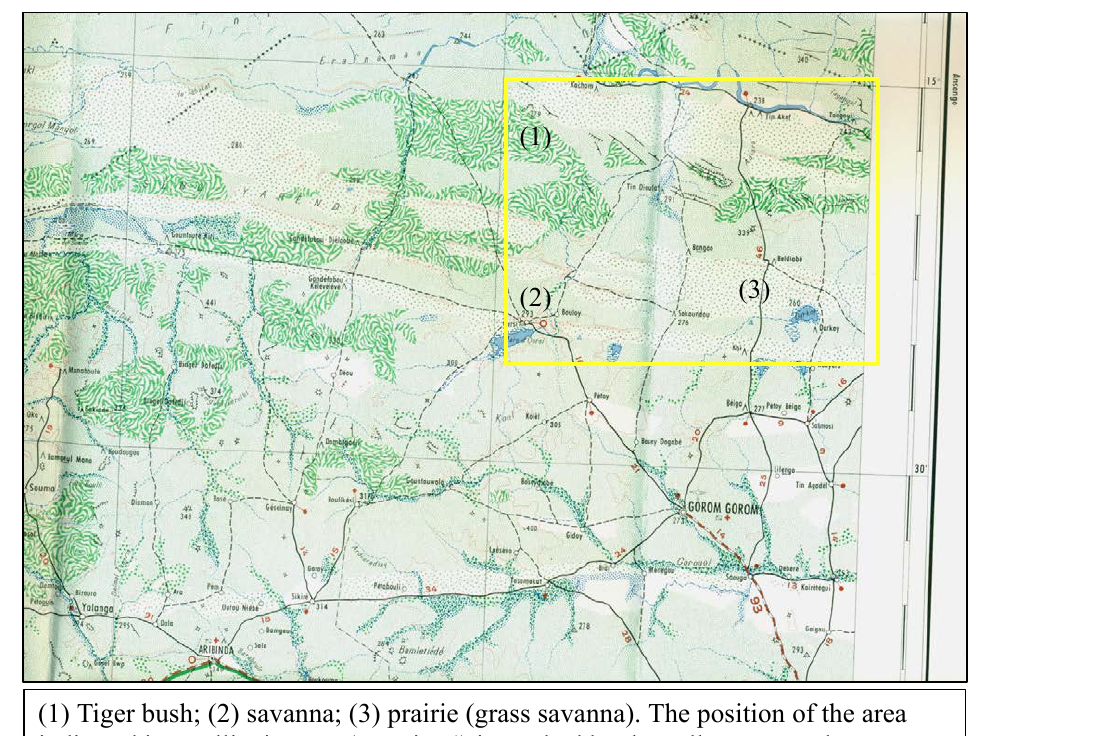
indicated in satellite images (see Fig. 4) is marked by the yellow rectangle. Figure 5. Section of the topographic map for Hombori (IGN, 1961) indicating the vegetation types of the early 1950s: (1) tiger bush; (2) savanna; (3) prairie (grass savanna). The box shows the position of the satellite image section (see Fig.